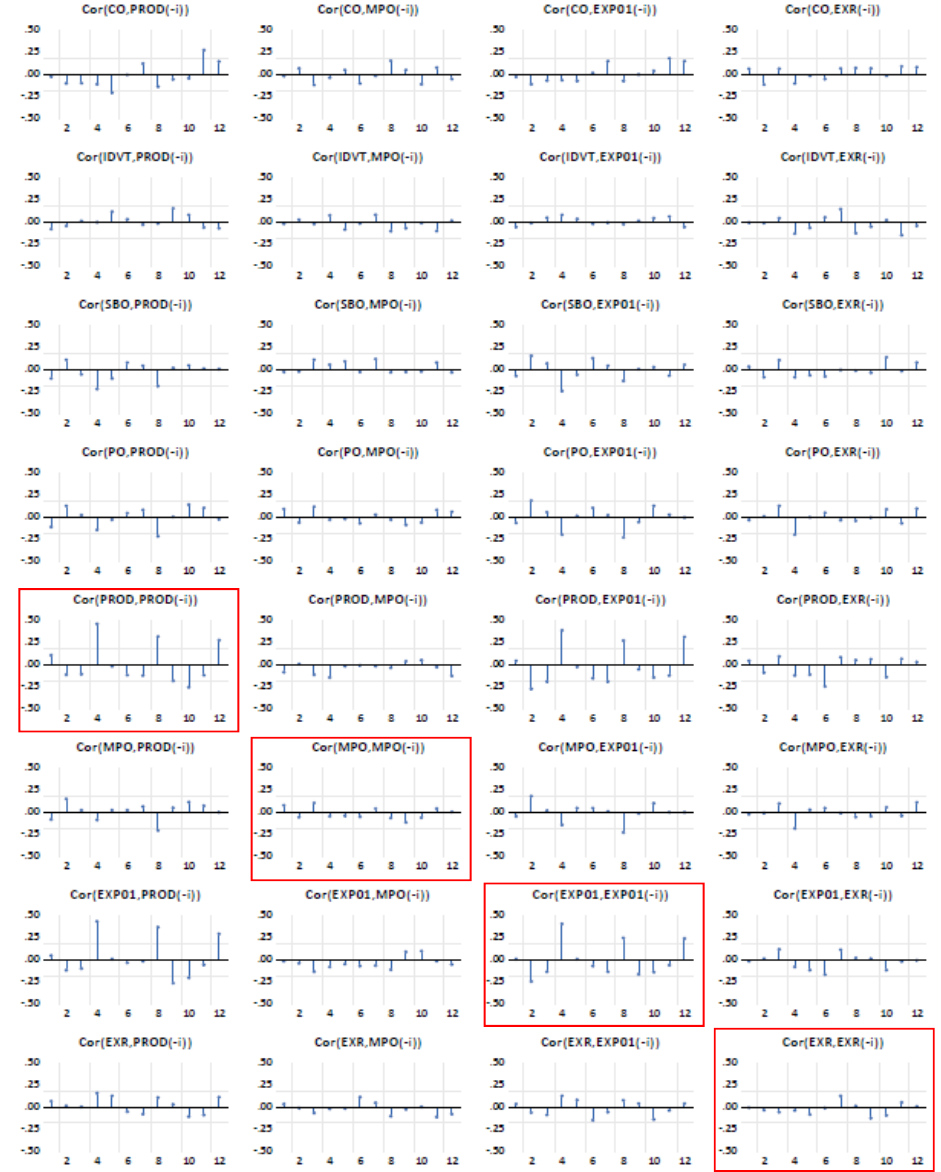
Figure A2. Plots of autocorrelation coefficients of error terms of any of the time series with its own lagged (diagonal) and also with the other time series’ lagged (o ff− diagonal) (continued from Figure A1).